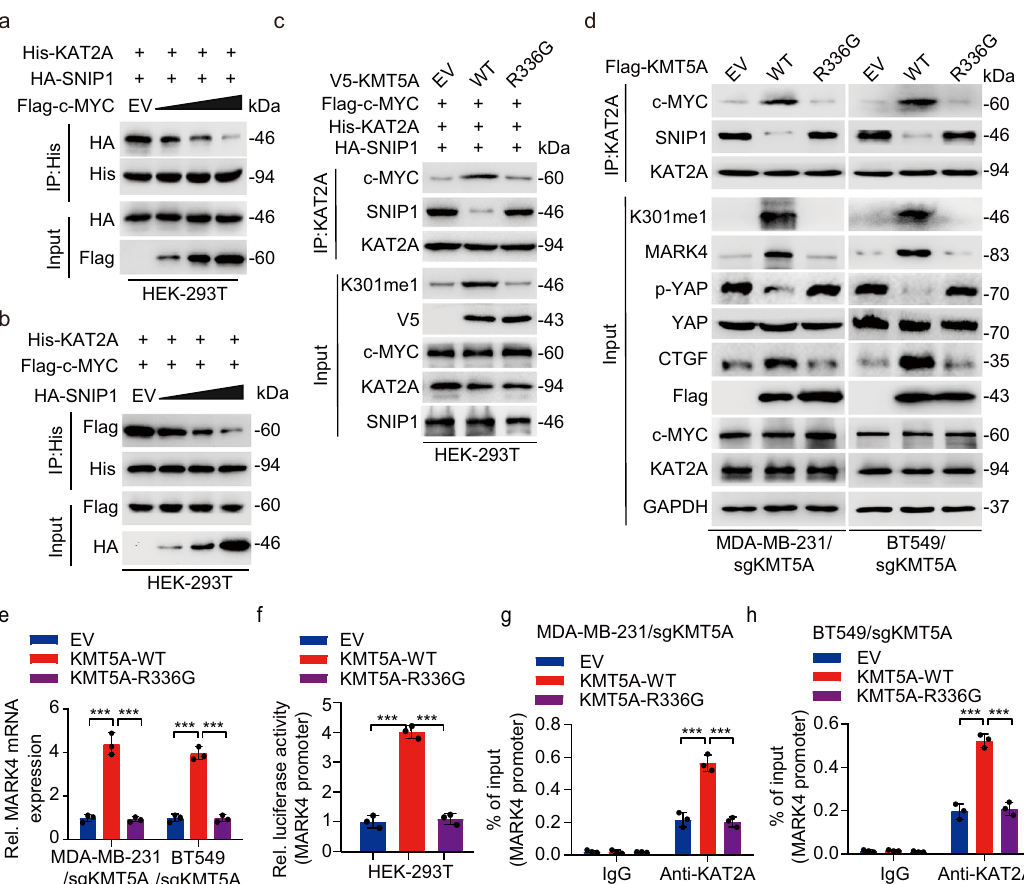
Fig. 6 KMT5A-mediated SNIP1 K301 methylation facilitates c-MYC-dependent recruitment of KAT2A to MARK4 promoter and activates the MARK4 transcriptional activity. a , b c-MYC overexpression disrupted KAT2A-SNIP1 interaction in HEK-293T cells ( a ). SNIP1 overexpression impaired KAT2A-c- MYC association in HEK-293T cells ( b ). HEK-293T cells were transfected with the indicated plasmids. 48 h after transfection, cells were harvested for co- immunoprecipitation ( n = 3). c KMT5A wild type but not the catalytically inactivated R336G mutant increased formation of the KAT2A/c-MYC complex and disrupted KAT2A-SNIP1 interaction in HEK-293T cells. HEK-293T cells were transfected with the indicated plasmids. The amount of c-MYC or SNIP1 bound to KAT2A was detected by immunoblot with the anti-c-Myc or SNIP1antibody, respectively ( n = 3). d Effects of KMT5A WT or KMT5A R336G mutant on KAT2A association with c-MYC and SNIP1, SNIP1 K301 methylation, MARK4 protein expression and the YAP signaling pathway activation. KMT5A sgRNA resistant KMT5A WT or KMT5A R336G constructs or empty vector control was respectively transfected into the MDA-MB-231/sgKMT5A and BT549/sgKMT5A cell lines ( n = 3). e Effects of KMT5A WT or KMT5A R336G mutant on MARK4 mRNA expression in MDA-MB-231/sgKMT5A and BT549/sgKMT5A cell lines ( n = 3). f Effects of KMT5A WT or KMT5A R336G mutant on MARK4 promoter transcription activity in HEK-293T cells ( n = 3). g , h These ChIP-qPCR results were used to measure the effects of KMT5A WT or KMT5A R336G mutant on the binding of KAT2A at MARK4 promoter in MDA-MB-231/sgKMT5A and BT549/sgKMT5A cell lines ( n = 3). Data information: In ( e – h ), statistical analysis was performed by two-tailed t